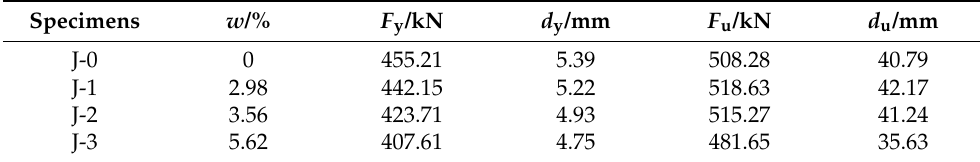
Table 7. Results of the tensile properties of the corroded bolt-sphere joints with members.